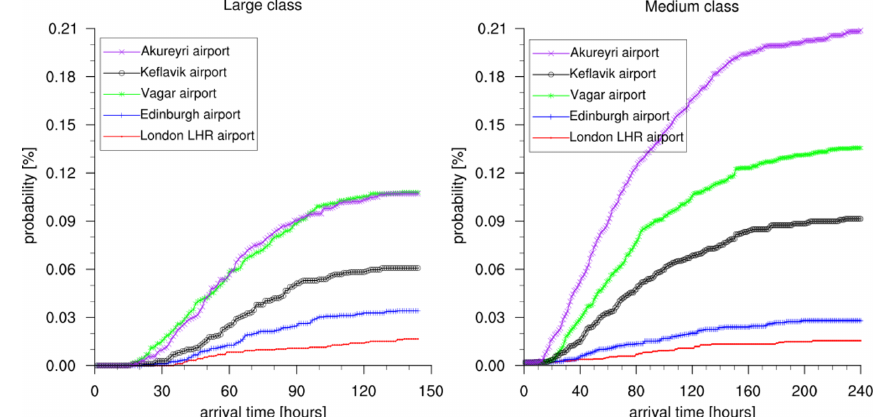
Figure 13. Exceedance probabilities vs. arrival times required for the ash concentration (at FL050) to exceed a threshold of 2mgm − 3 at different airports for medium and large eruptions from the beginning of the eruption.